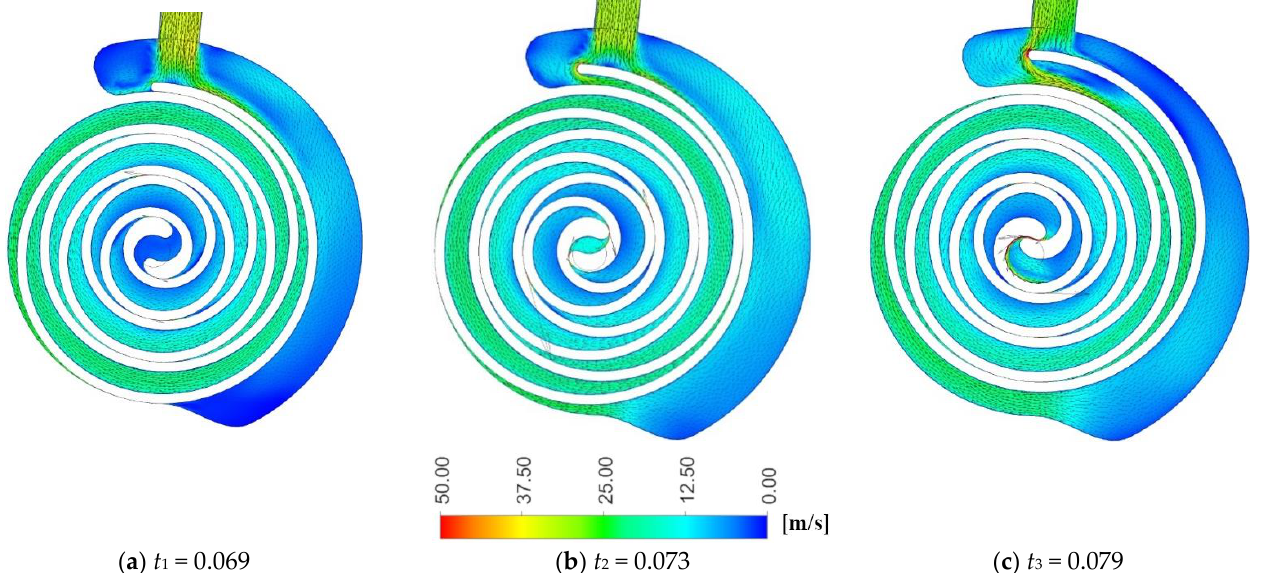
Figure 7. Vector plots of the flow field at mid-span for three different instants during the last revolution (CFX).